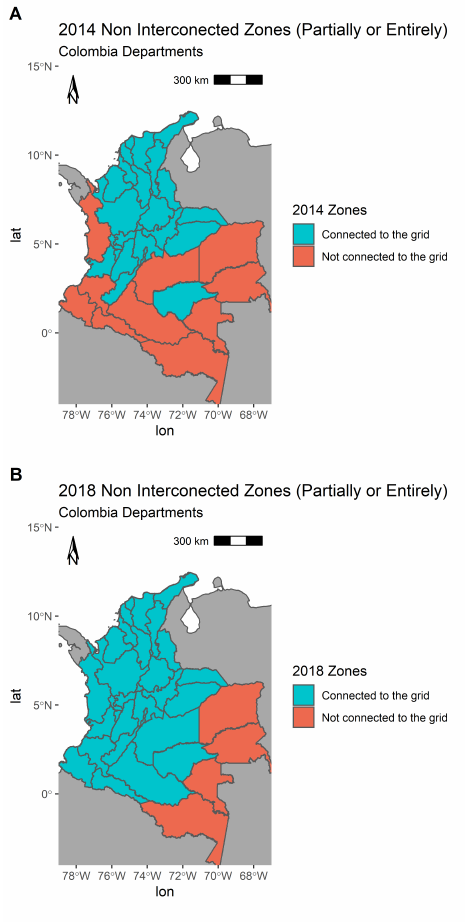
Figure 1. Energy access in Colombia. Zones partially or entirely non-connected to the national energy grid. ( A ) 2014. ( B )